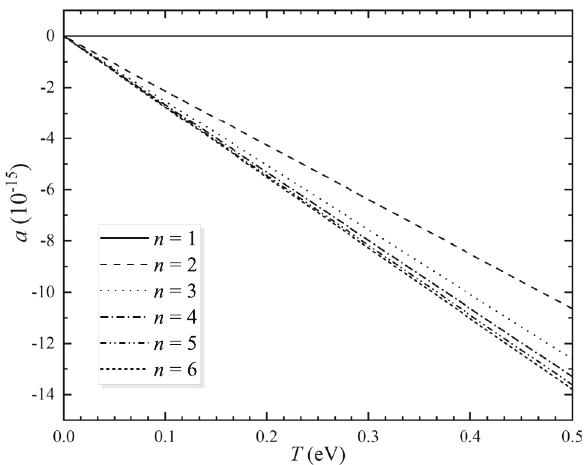
Fig. 2 The evolution of the a -parameter with temperature for some energy levels of the hydrogen atom according to Eq. (26) q η q = ρ (cid:2) q /( m ) is constant, since (cid:2) q = (cid:2) q ( 1 + z ) 3 c 0 p n γ 0 b b 0 b b 0 ( 1 + z ) 3 . Wherefore, we can reasonably assume and n q γ = n q γ 0 ≈ η = 2 . 75 × 10 − 8 (cid:2) 2 so that Eq. (27) can that η q b b 0 h b